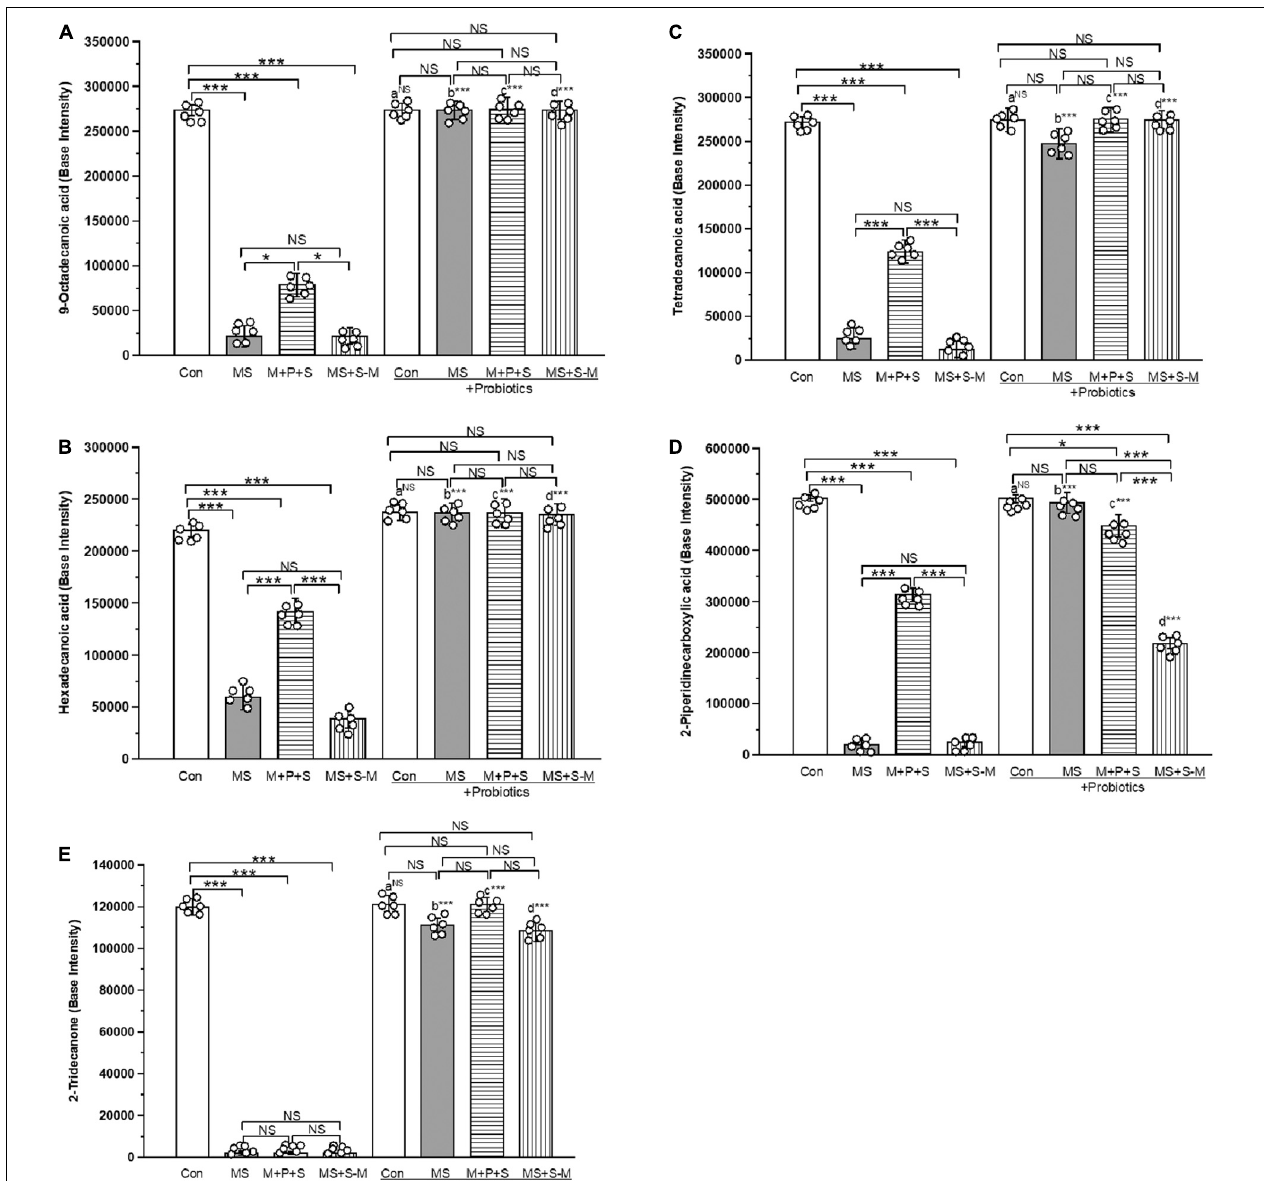
FIGURE 10 | GCMS analysis revealed that early life SSE induced changes in metabolites. whereas, Lactobacillus supplementation prevented the effect on early life SSE in (A) 9-octadecanoic acid, (B) hexadecanoic acid, (C) tetradecanoic acid, (D) 2-piperidinecarboxylic acid, and (E) 2-tridecanone. Values are presented as mean ± SEM. Significant differences between groups are indicated by *** P < 0.001, * P < 0.05; a: con vs. con + Pro; b: MS vs. MS + Pro; c: M + P + S vs. M + P + S + Pro; d: MS+S–M vs. MS+S–M + Pro; NS, not